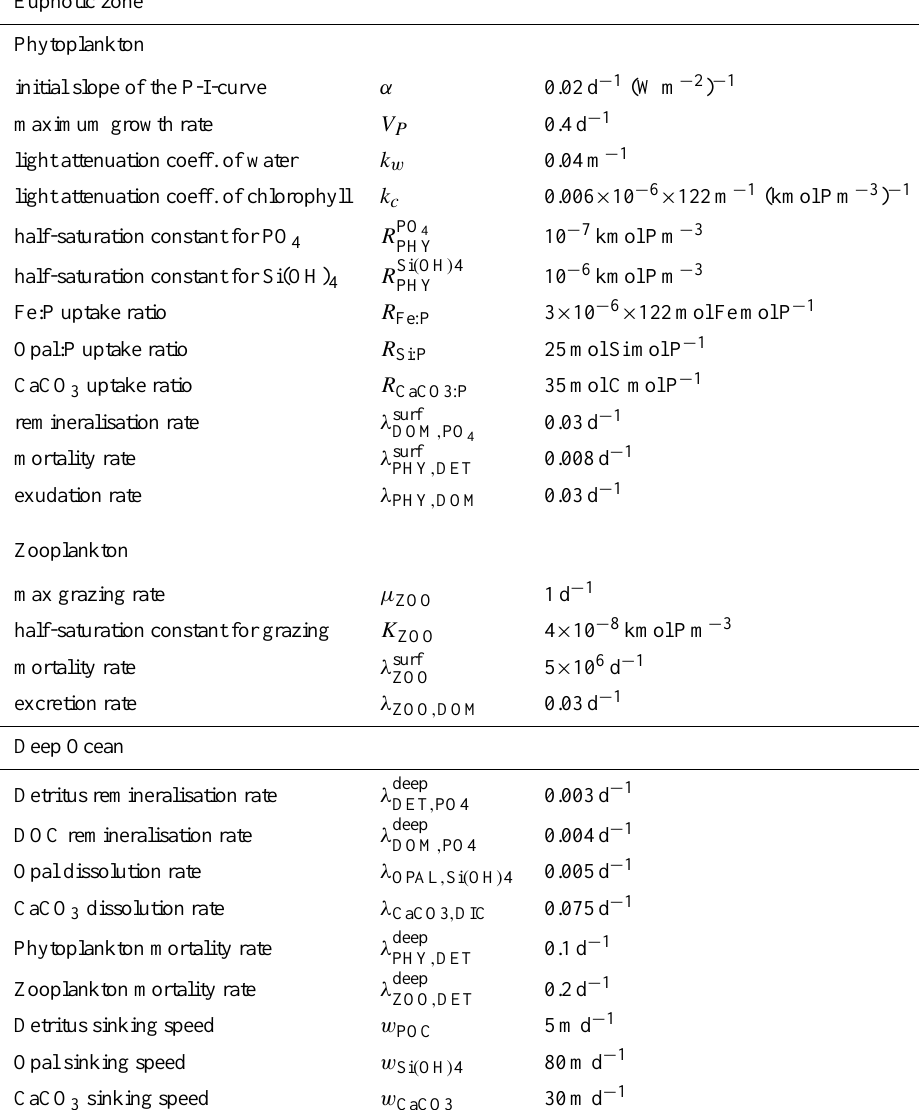
Table 1. HAMOCC parameters, their symbols and values in the reference experiment. Euphotic